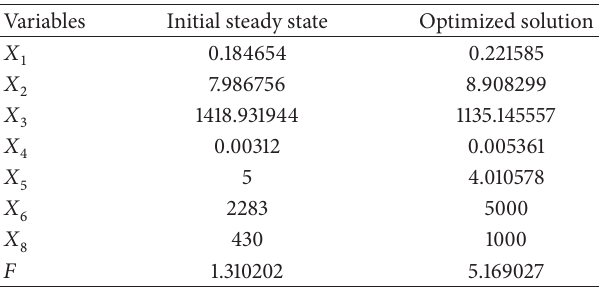
Table 1: Optimal solution of Case study 1 obtained by using the proposed approach ( 𝑠 (0) 3 = 1.99